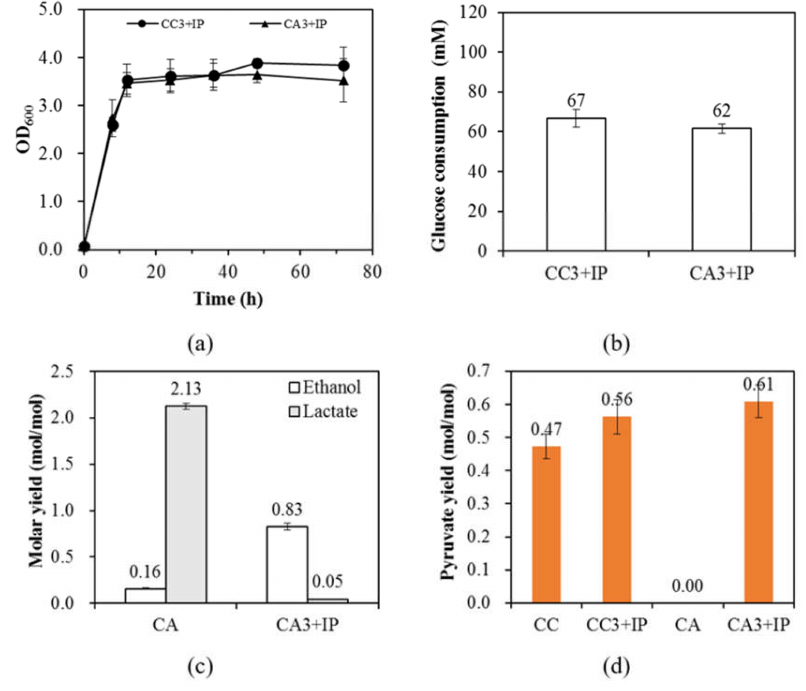
Figure 3. ( a )The growth curve and ( b ) glucose consumption of E. coli strains CC3 + IP and CA3 + IP. ( c ) The ethanol and lactate yields of E. coli strains CA and CA3 + IP and ( d ) the pyruvate yield of